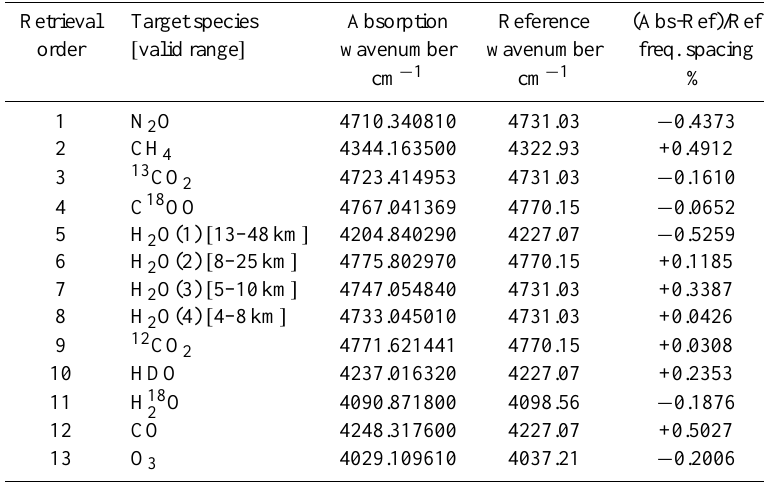
Table 1. Trace species retrieval order, associated absorption and reference wavenumbers, and their frequency spacing.